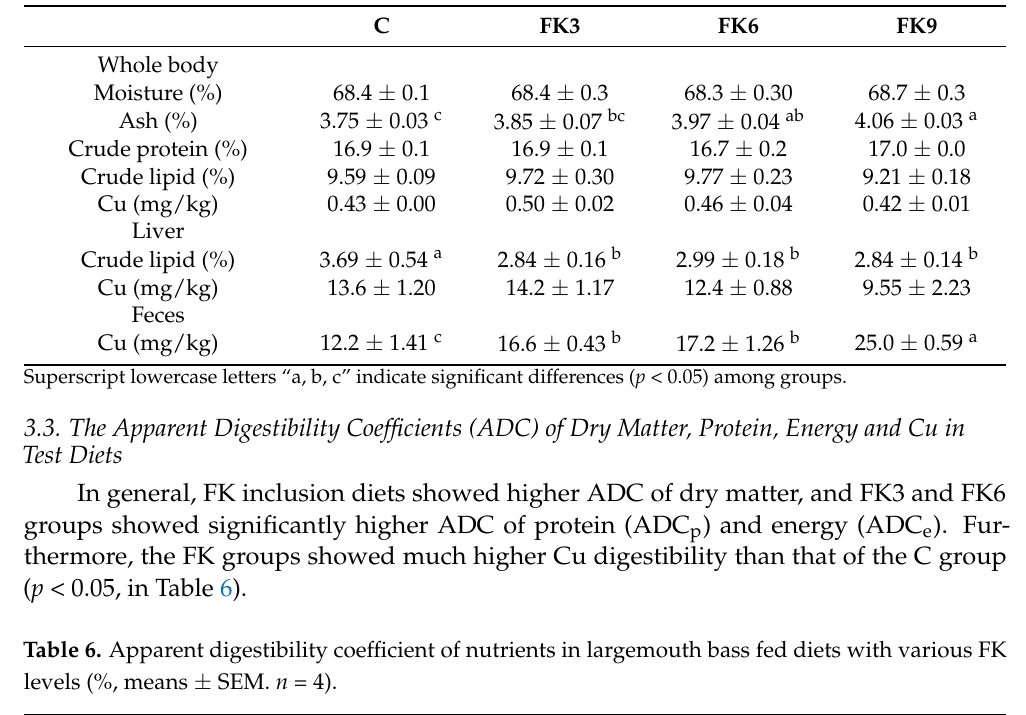
Table 5. Macro-nutrient compositions and Cu content in whole body, liver tissue and feces of largemouth bass fed diets with various FK levels (in wet basis, means ± SEM. n = 4).